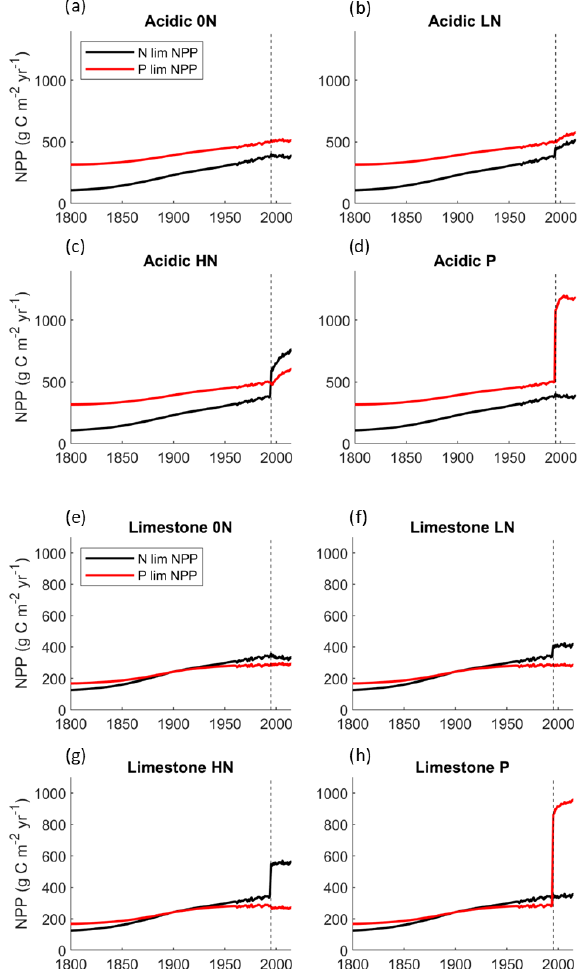
Figure 3. Plots showing the nutrient most limiting productivity for all nutrient treatments in both simulated grasslands. The ver- tical dashed line is the year of the first nutrient addition within the model (1995). The value of the lines represents the maximum amount of productivity attainable given the availability of N and P separately. Due to Liebig’s law of the minimum approach to plant growth, it is the lowest of the two lines that dictates the limiting nu- trient of the grassland and represents actual modelled productivity. Where lines share a value, it can be considered in a state of N–P